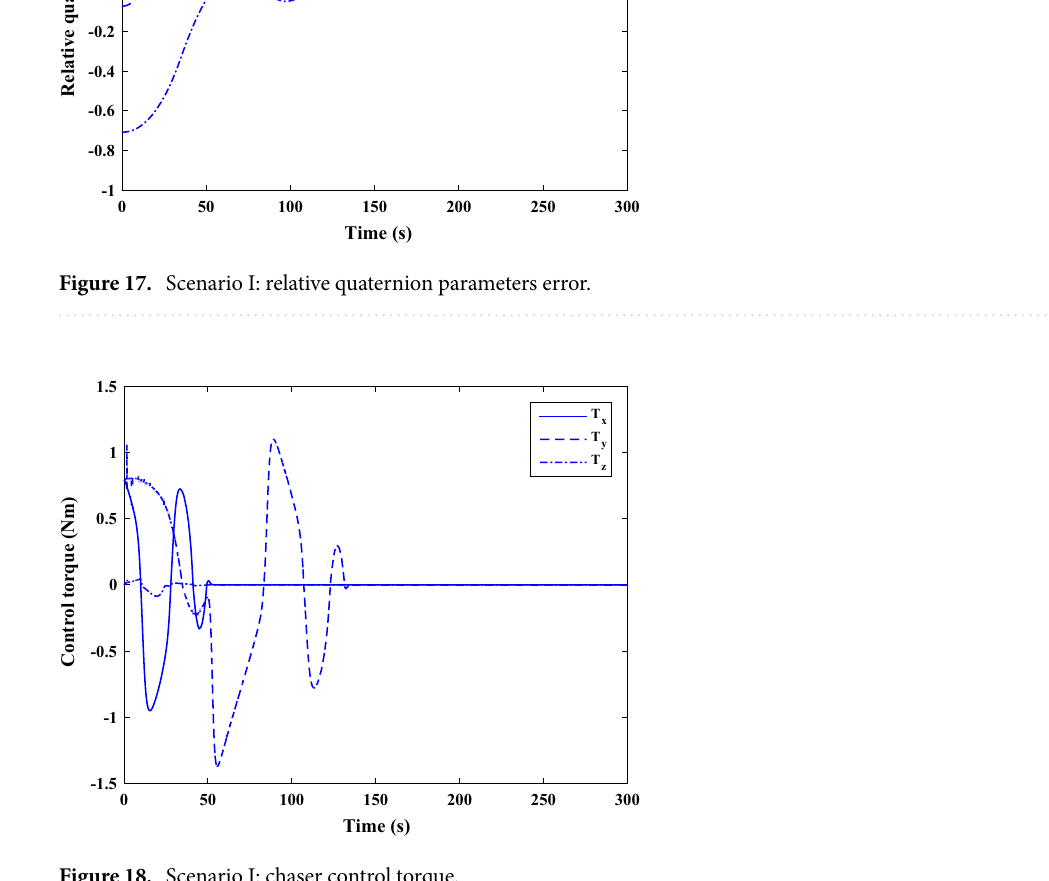
Figure 18. Scenario I: chaser control